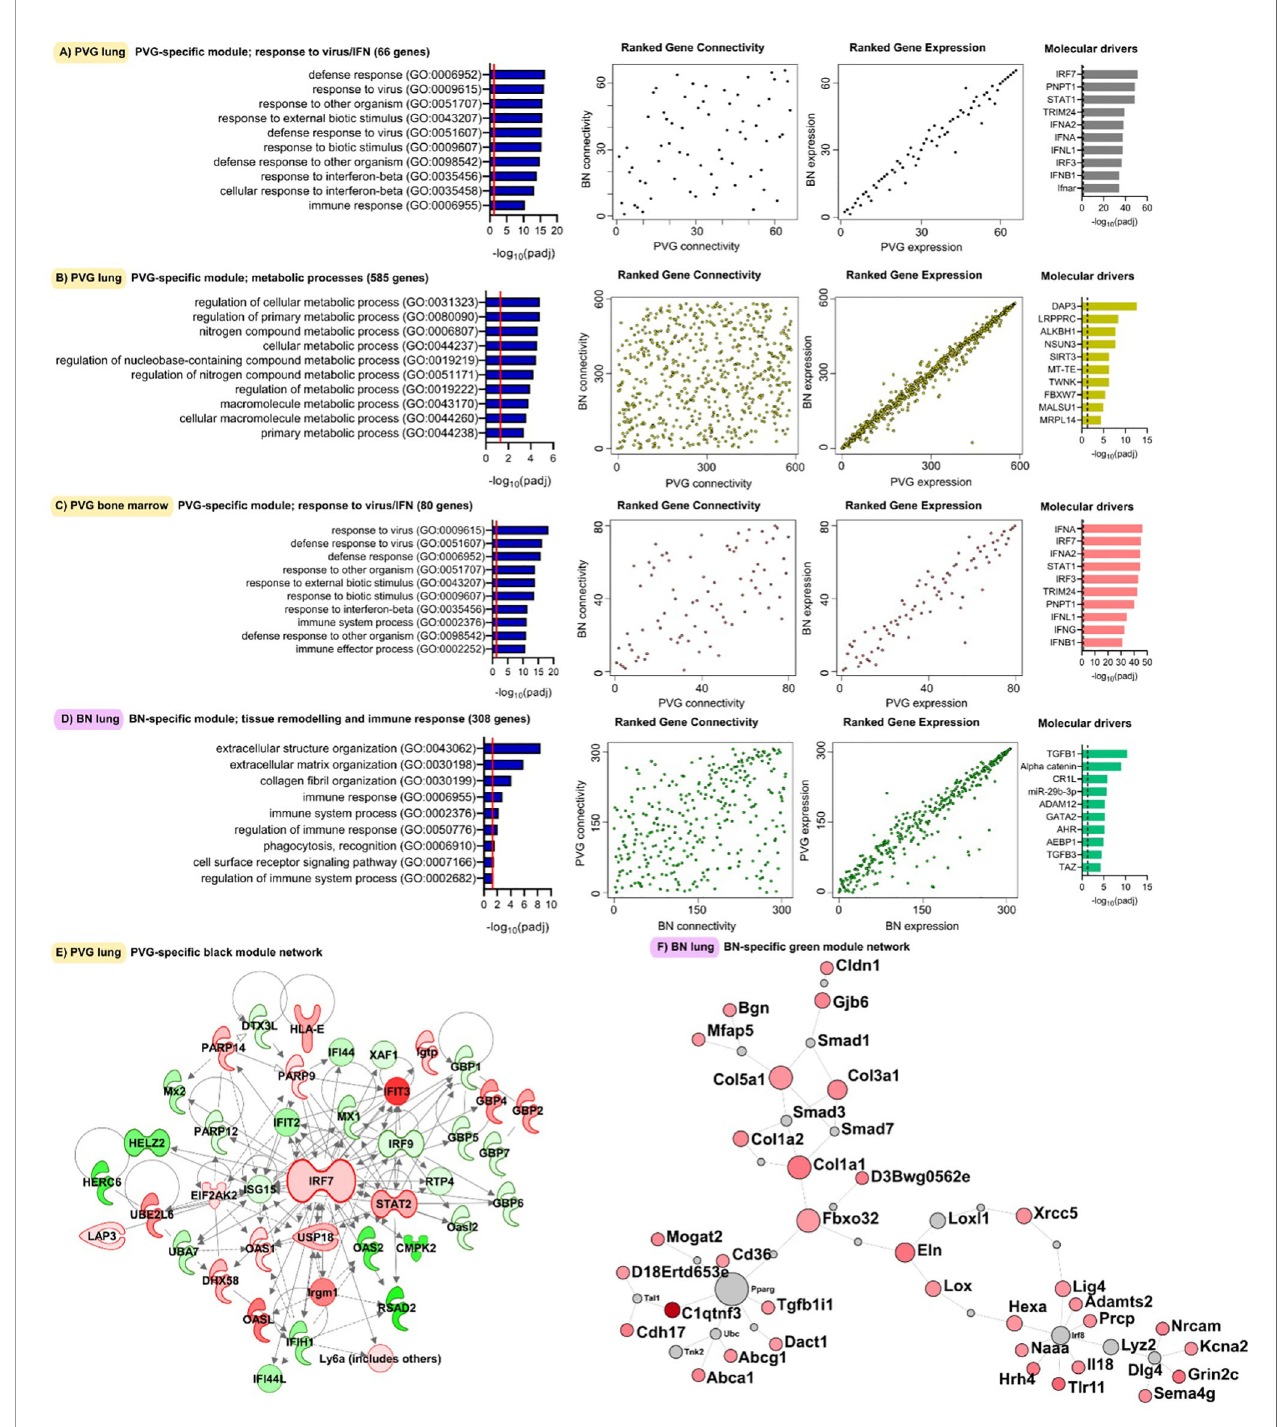
FIGURE 3 | Functional gene networks unique to either PVG or BN rats. The four gene network modules unique to either PVG lung (A, B) , PVG bone marrow (C) or BN lung (D) . Over-represented biological pathways are shown for each module, the red line at 1.3 represents the threshold for signi fi cance equivalent to a Bonferroni-corrected p-value <0.05. For each network module, ranks of gene connectivity (re fl ecting the relative importance of that gene within the network module) and gene expression were calculated for both PVG and BN: correlation plots between rat strains are shown. The top ten predicted molecular drivers are shown for each module, where the dashed line represented the threshold for signi fi cance. Prior knowledge network reconstructions are shown for the PVG lung black module (E) and the BN lung green module (F) where red and green coloring indicate increased and decreased expression respectively on day 2 (for E ) and day 9 (for F ) relative to day 0. Sample sizes for network construction: BN bone marrow n = 47, PVG bone marrow n = 49, BN lung n = 48, PVG lung n =